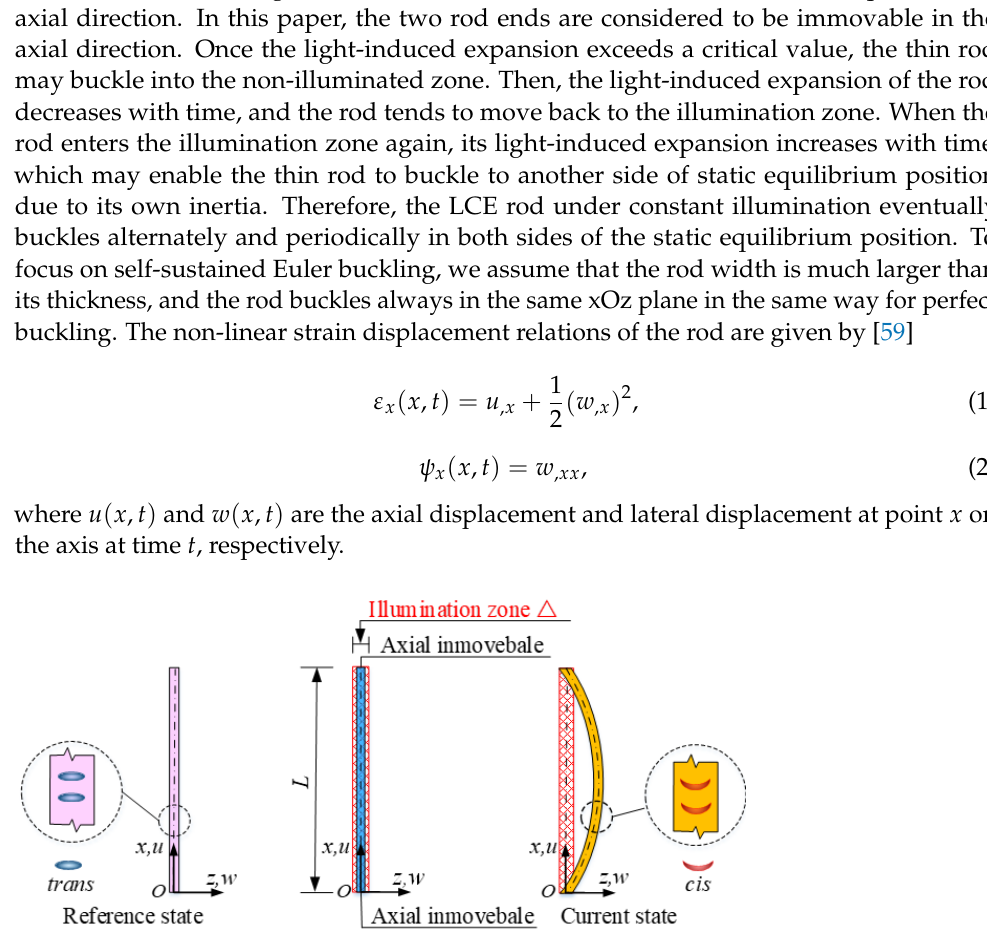
Figure 1. Schematics of an optically responsive LCE rod with length L , cross-section area A , and area moment of inertia J , which is capable of self-sustained Euler buckling under steady illumination with narrow zone ∆ near its static equilibrium position. Its two ends are considered to be immovable in the axial direction. The azobenzene liquid crystal molecules in the rod are perpendicular to its axis and transform from straight trans to bent cis under illumination, giving rise to the rod’s shrinkage in the transverse direction and expansion in the axial direction.